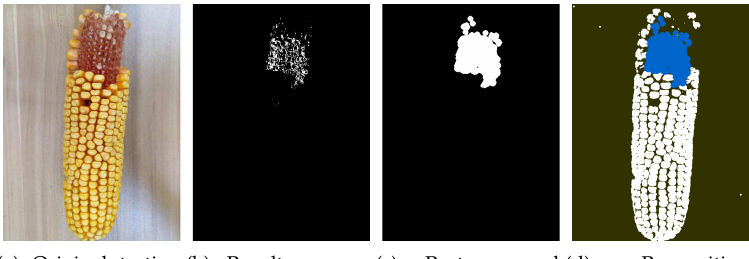
Figure 7. Determination on region of ear damage.